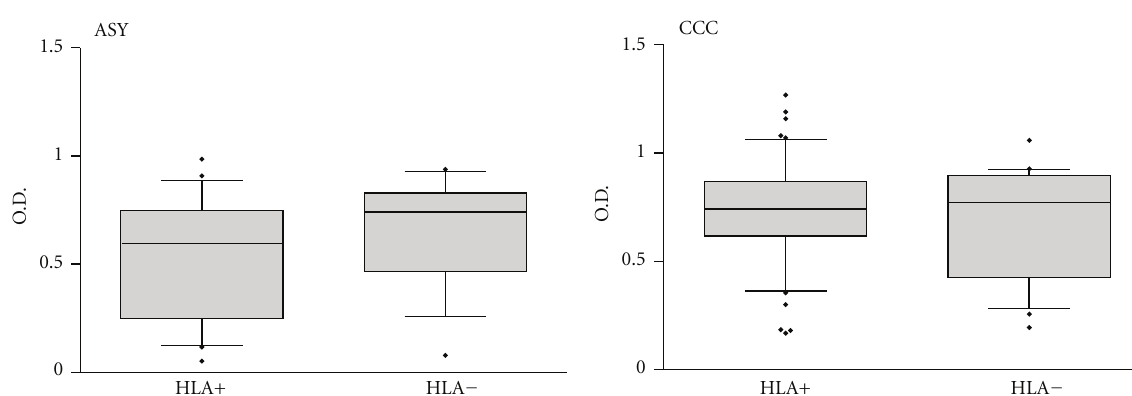
Figure 3: Direct ELISA for total IgG reactivity to recombinant B13 protein in the solid phase. The HLA+ group (subjects bearing HLA alleles capable of presenting B13 peptides to T cells,HLA-DQ7, DR1, and DR2); and the HLA − group (subjects bearing other HLA alleles). The horizontal bar indicates median absorbance in each group.